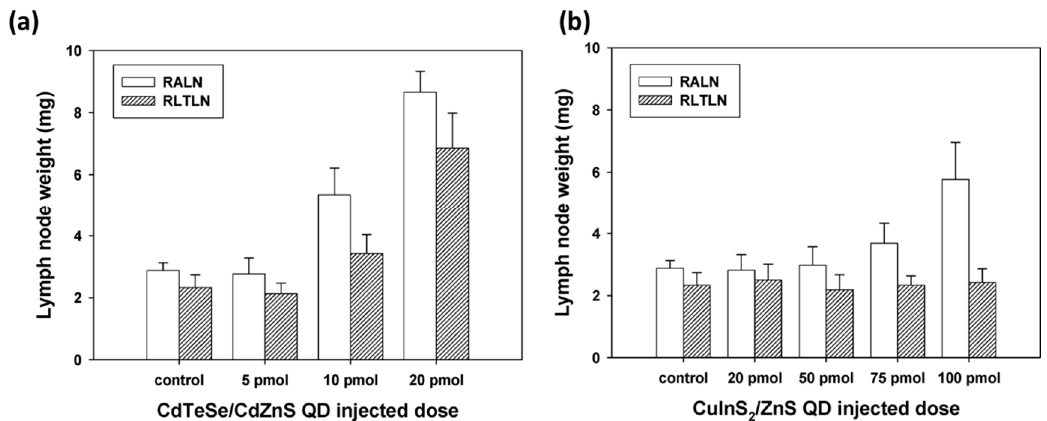
Figure 14. Weight of the right axillary LN (RALN) and right lateral thoracic LN (RLTLN) dissected 7 days post-injection as a function of the QD-injected dose for CdTeSe/CdZnS (left panel) and CuInS 2 /ZnS (right panel) QDs. The data are mean ± SEM ( n = 6 per group) [102].